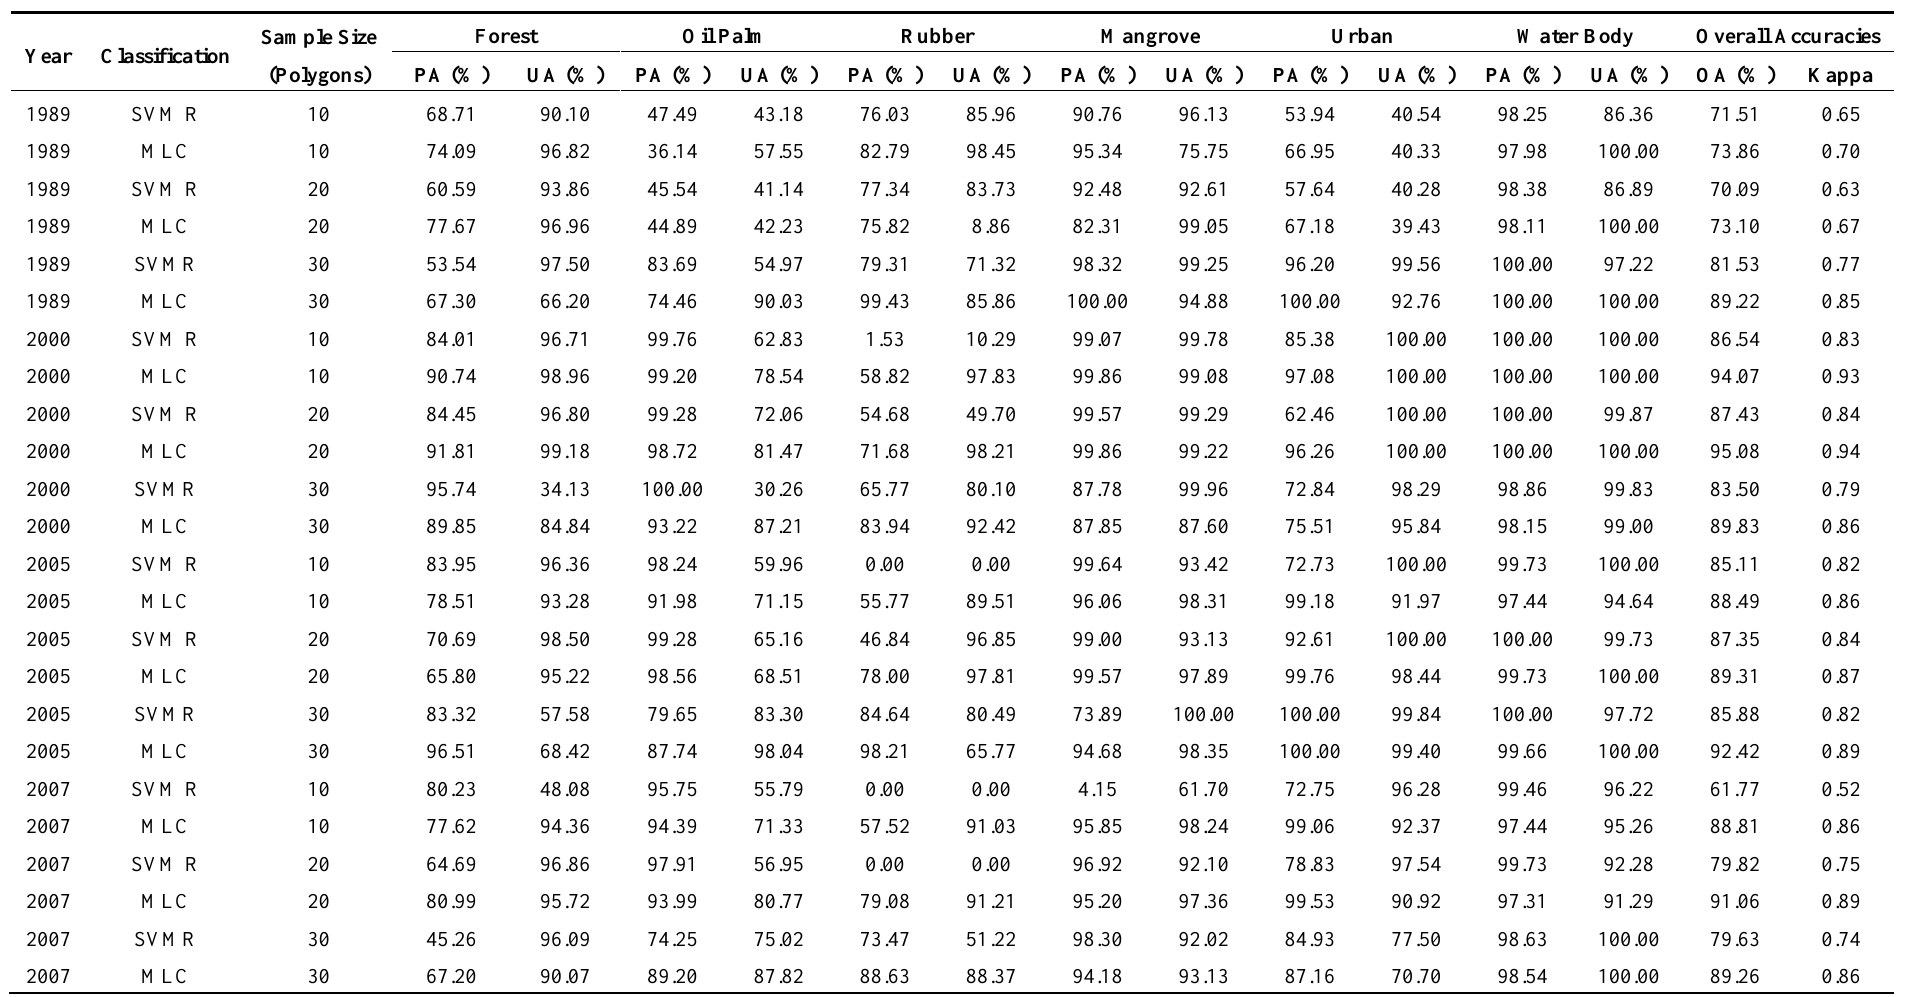
Table 2. The user and producer accuracies of Landsat imageries using Maximum Likelihood (MLC) and Support Vector Machine (SVM) classification techniques. SVM R refers to the Radial function of